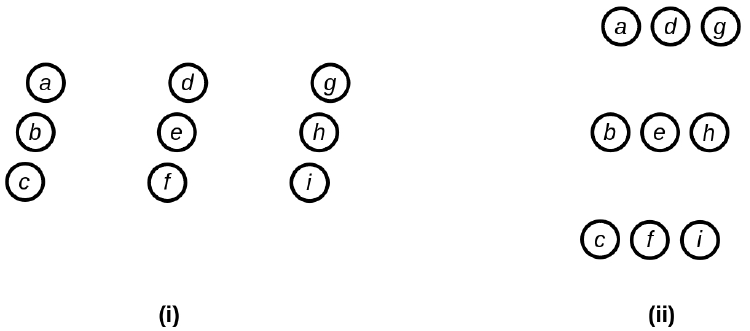
Figure 2. Illustration of the Gestalt principle of proximity. The most natural arrangement in ( i ) would be abc/def/ghi; the most natural arrangement in ( ii ) would be adg/beh/cfi (inspired by